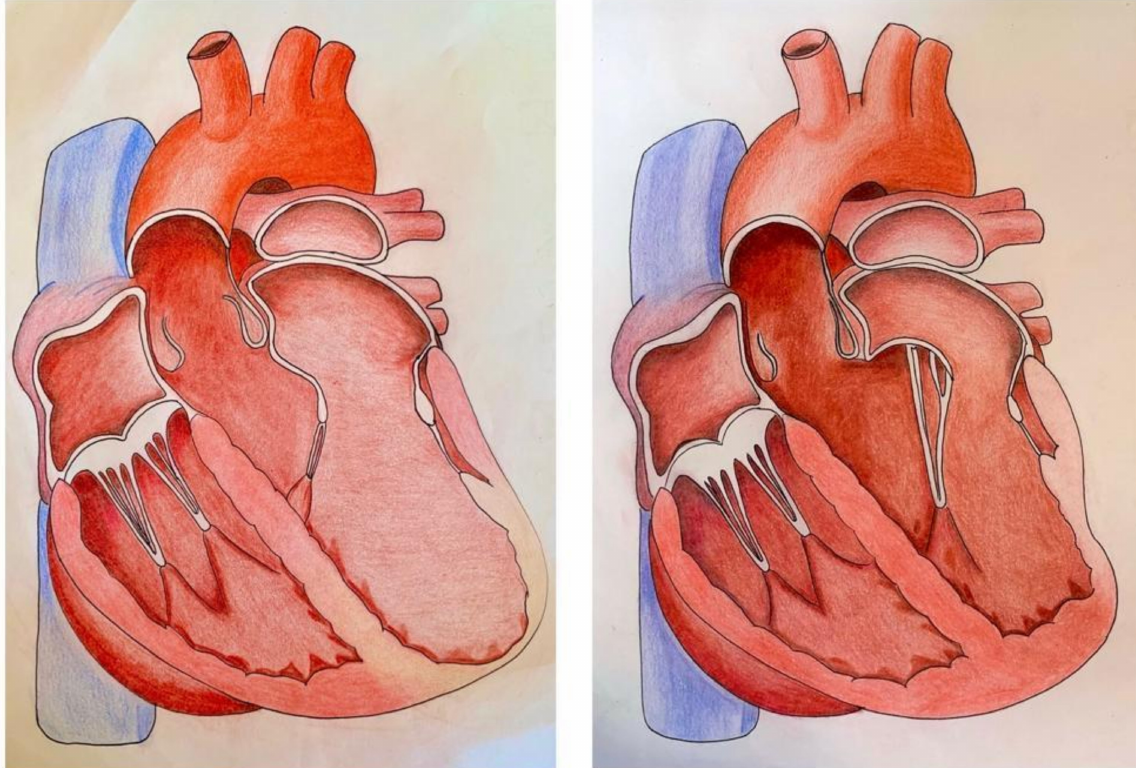
Figure 1. The two main different phenotypes of ischemic mitral regurgitation (IMR): on the left, left ventricle (LV) is globally dilated, displacement of papillary muscles (PMs) is symmetrical, leading to symmetric systolic tethering of mitral valve (MV) leaflets; on the right, inferior-posterior acute myocardial infarction (AMI) causes asymmetric tethering of MV leaflets with an excessive systolic restriction of posterior MV